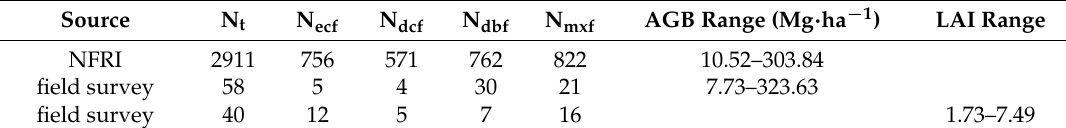
Table 1. Summary of field data: N t is the total number of all field forest plots; and N ecf , N dcf , N dbf , and N mxf are the total number of evergreen coniferous forest, deciduous coniferous forest, deciduous broadleaved forest, and mixed forest plots, respectively.